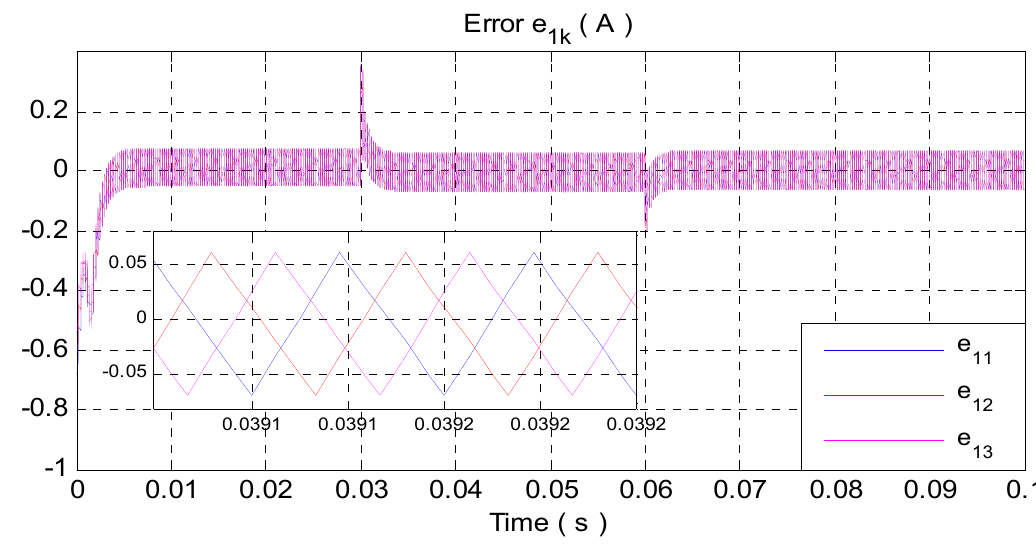
Figure 8. Error e 1 k between inductance current in each IBBC branch and its reference.